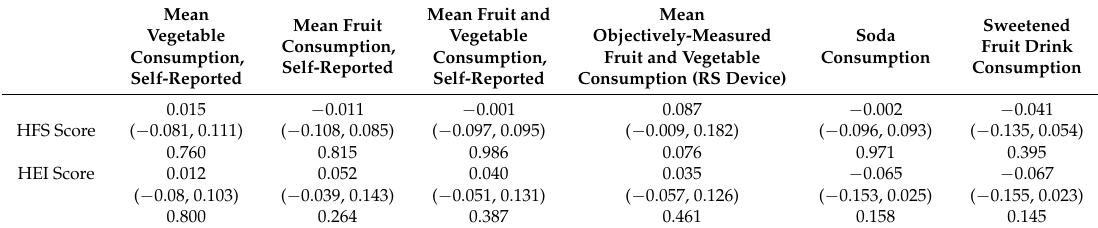
Table 3. Pearson’s correlation coefficients, 95% confidence intervals, and p -values between store-level Healthy Food Supply Scores, store-level Healthy Eating Index Scores, and individual-level fruit and vegetable, soda, and sweetened fruit drink consumption.